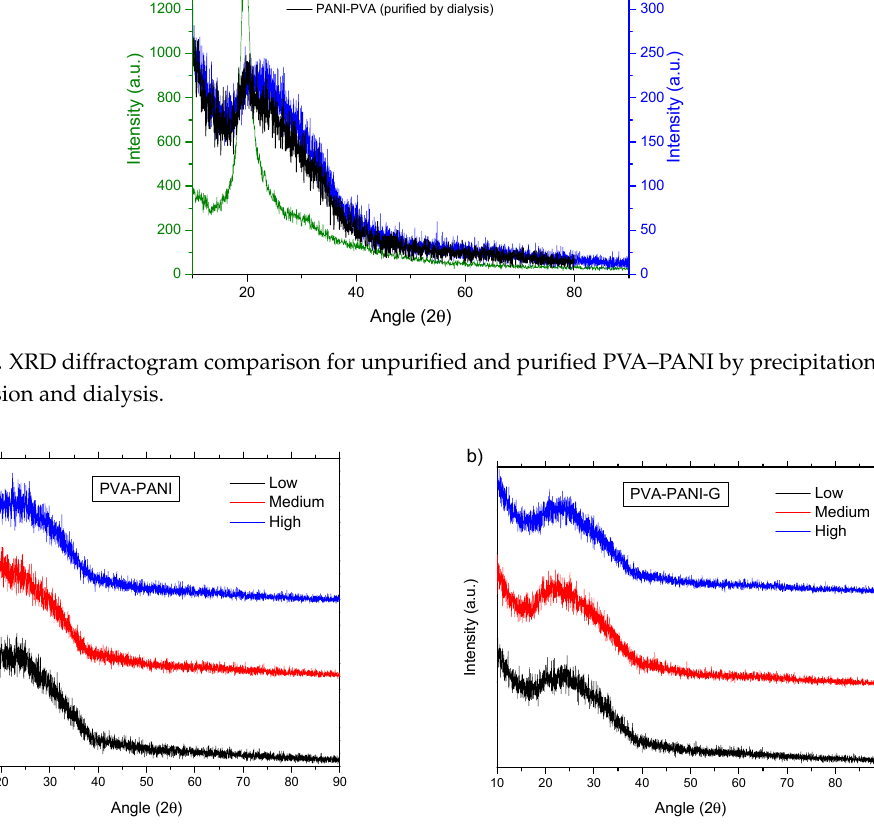
Figure 17. SEM micrographs of purified PVA–PANI thin films and its morphologic variations at ( a ) low concentration, ( b ) medium concentration, and (( c ), ( d )) high concentration. The morphology of the particles presents as needles which changed with increasing aniline concentration, generating particles in granular form which tend to agglomerate in different nucleation points, according to the reports of Gangopadhyay et al. [12]. On the other hand, the morphology observed for both PVA–PANI and PVA–PANI-G purified by dialysis maintained a spherical shape with an average size of 156 nm (Figure 18), which has been reported for various PANI synthesis processes [37]. This indicates that the precipitation–redispersion process (Figure 17) influences morphological changes in the material, along with pH, temperature, and solvents used.